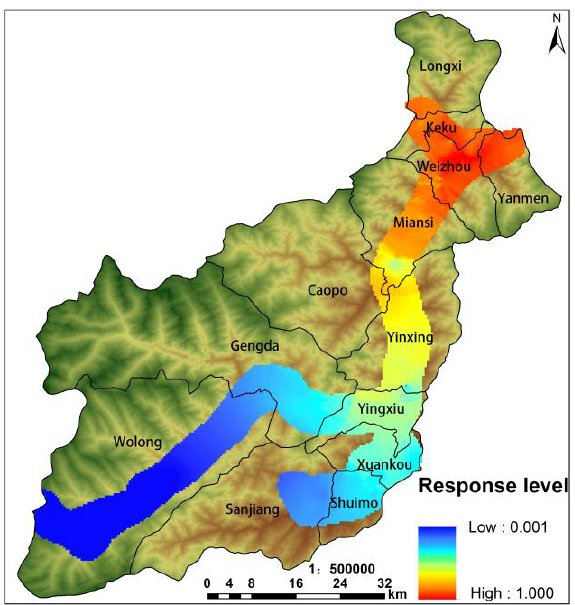
Figure 5 . Travel factors statistics (10 levels).